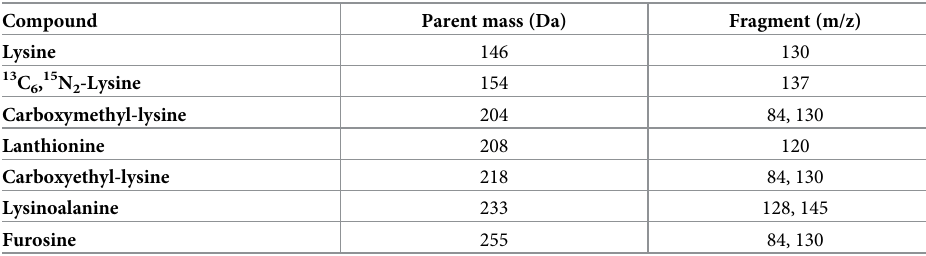
Table 2. Selected reaction monitoring